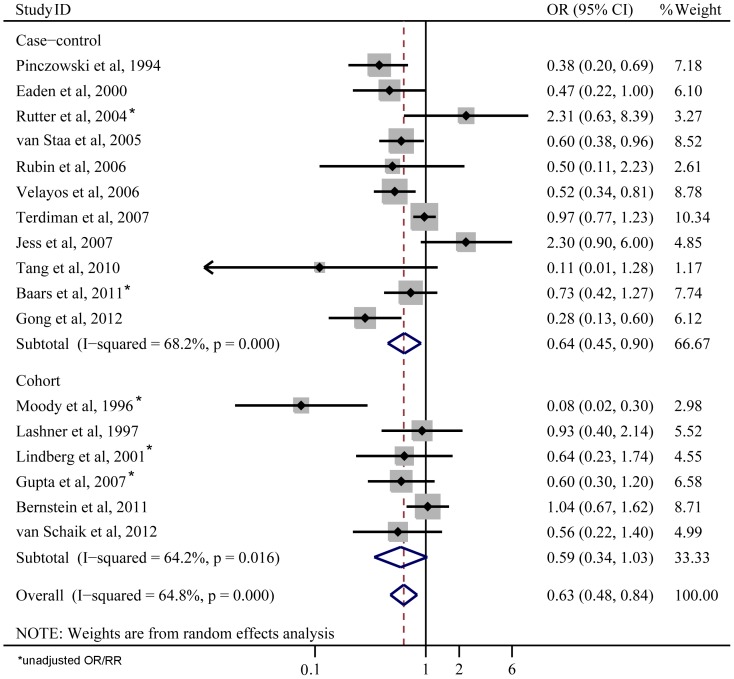
Forest plot (random-effects model) of 5-ASA use and colorectal neoplasia.